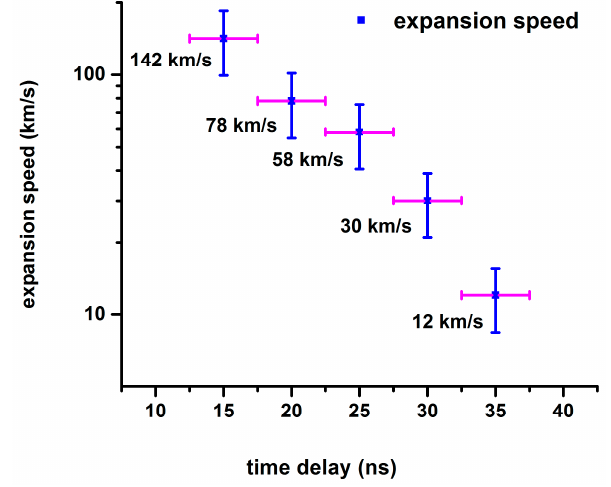
Figure 3. Plasma expansion speeds in log scale (see Table 1). The indicated time-delay error bars are due to the gate width of 5 ns.